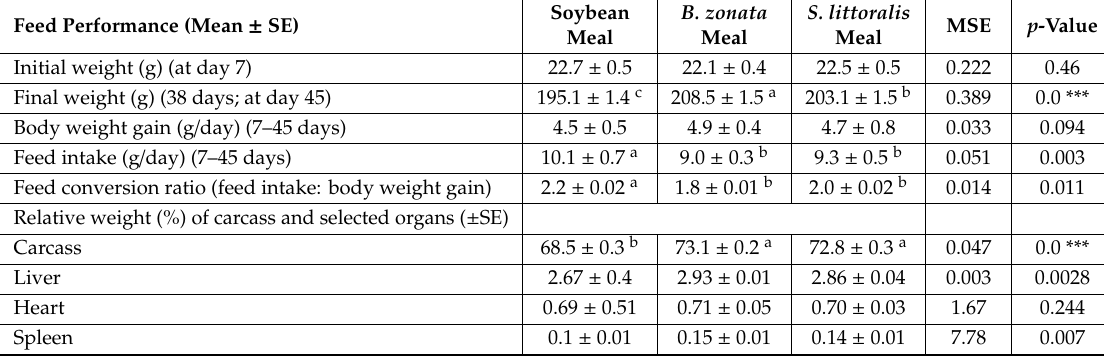
Table 6. Average live body weight, feed intake and relative weight (%) of carcass and selected organs in Japanese quails along the trial, depending on the